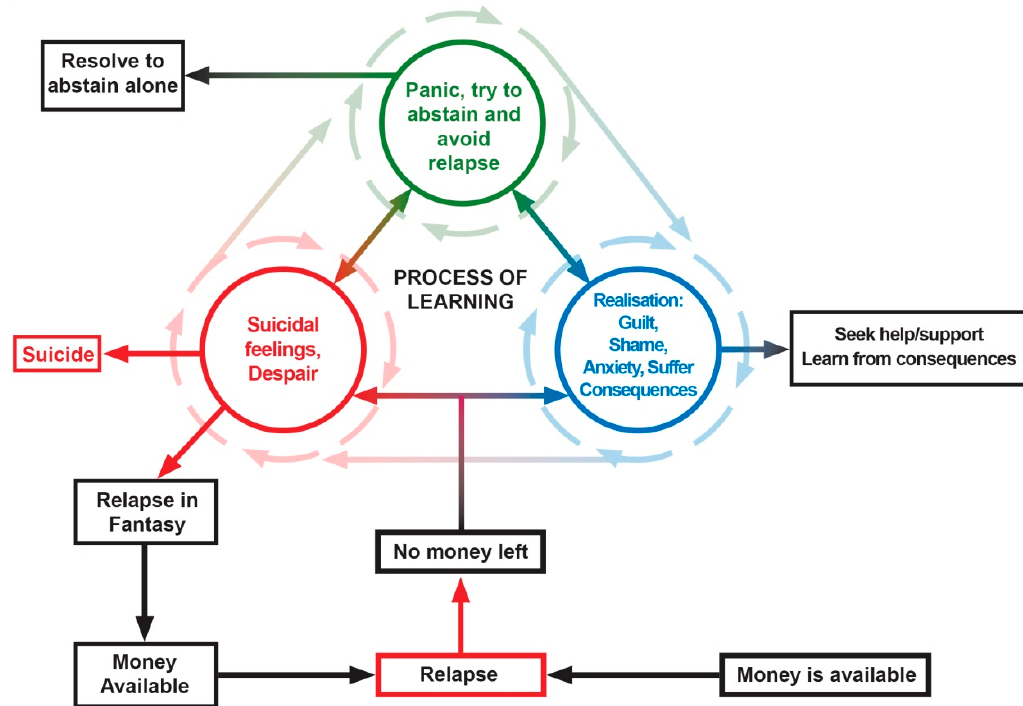
Figure 1. The ‘Merry-Go-Round’ of Relapse.